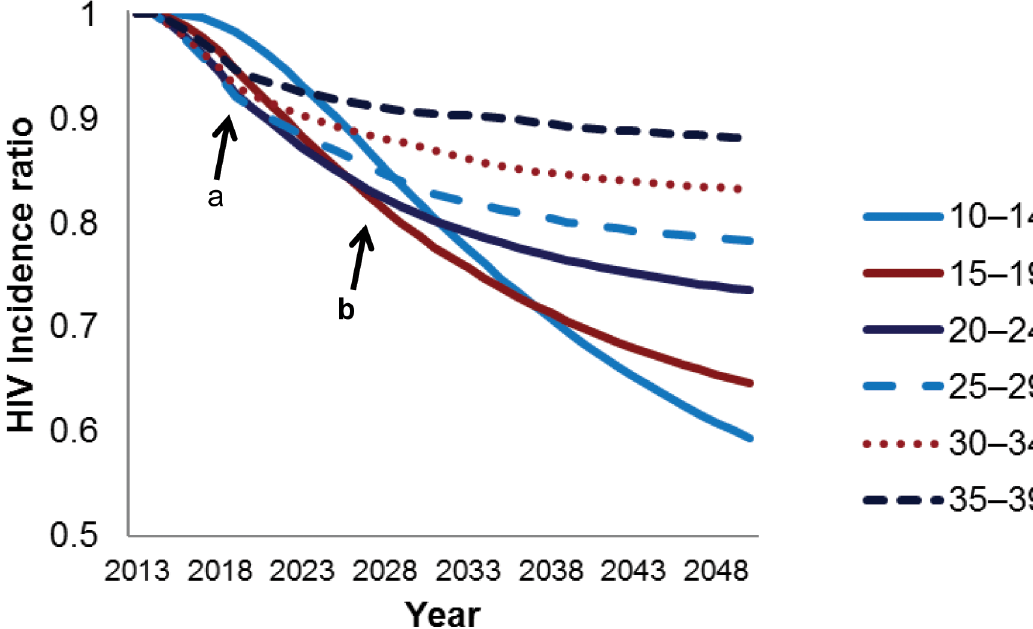
Fig 1. Reduction in HIV incidence with provision of VMMC to males, by age group, 2014 – 2050. The HIV incidence ratio represents the incidence in the scale-up scenario divided by the incidence in a population where circumcision is not scaled up over baseline levels. HIV incidence is in the entire population — males and females. Each line represents the HIV incidence ratio under a scenario in which only the indicated five-year age group is circumcised. Marker a represents a five-year period from the base year (2014). Marker b represents a 15-year period from the base